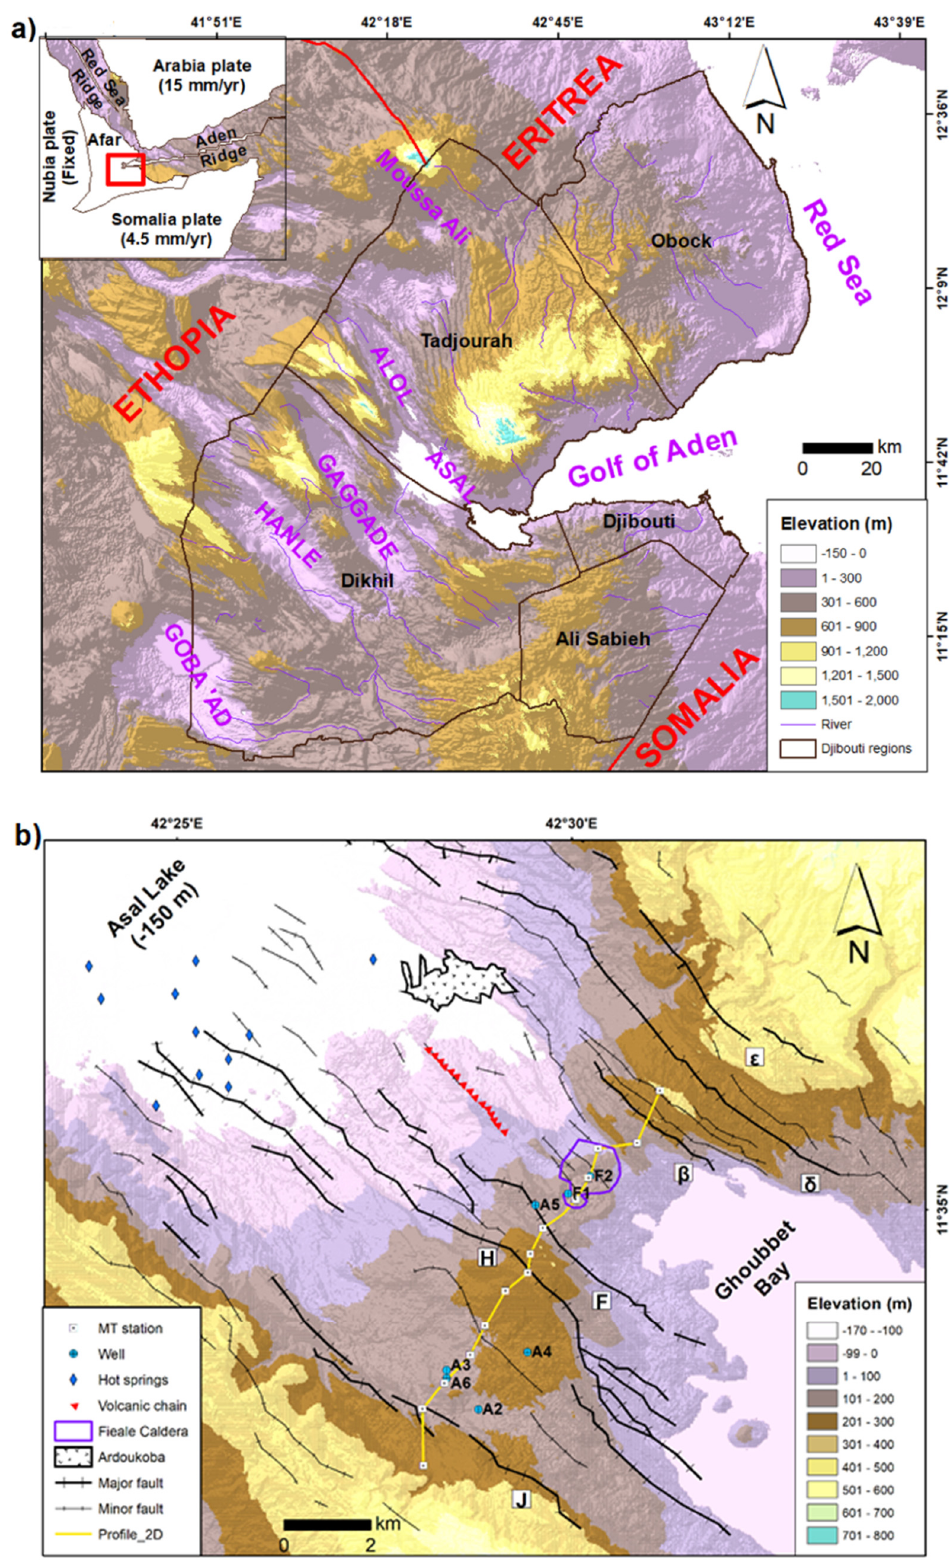
Figure 1. Topographic and main structural elements of ( a ) Djibouti and ( b ) Asal rift. The red rectangle is Djibouti; Greek characters represent the name of major normal faults; MT: Magnetotelluric (modified from [6]).